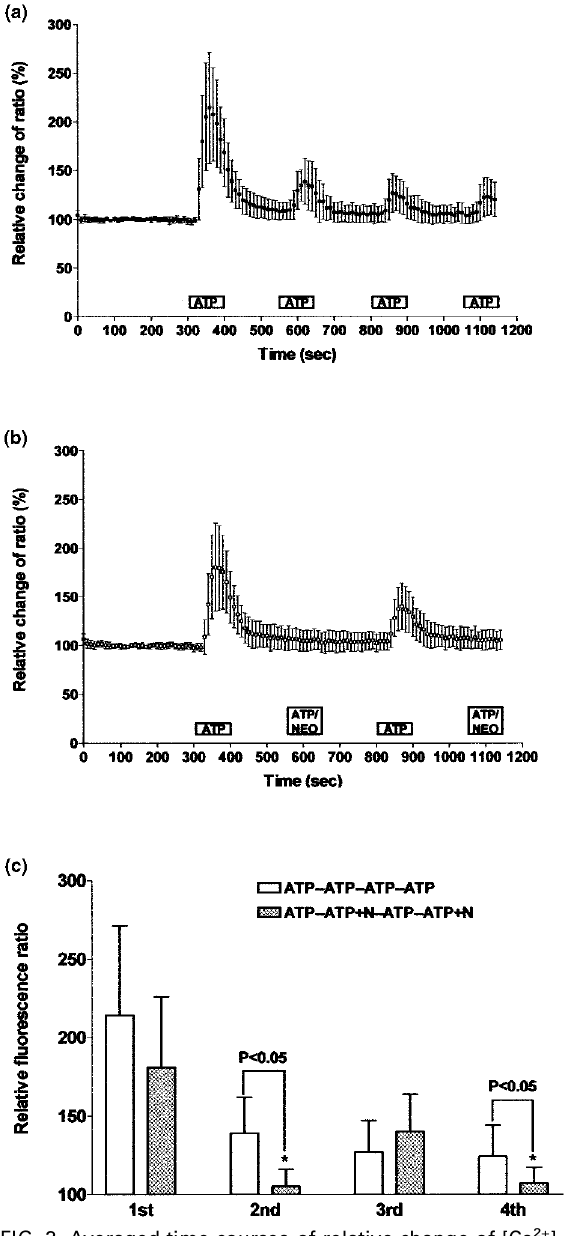
FIG. 3. Averaged time courses of relative change of [Ca 2+ ] i . (a) Each of four consecutive applications of ATP induces an increase in [Ca 2+ ] i . Data are presented as mean ± SD of cells. (b) Application of ATP induces an increase in [Ca 2+ ] i , whereas simultaneous application of ATP and neopterin (NEO) fails to change [Ca 2+ ] i . Data are presented as mean ± SD of 200 cells. (c) Comparison of maximal changes in fluorescence ratio for both the first (open bars) and the second (hatched bars) experimental protocols. 1st, ATP versus ATP; 2nd, ATP versus ATP + neopterin (N); 3rd, ATP versus ATP; 4th, ATP versus ATP + neopterin. * Significant